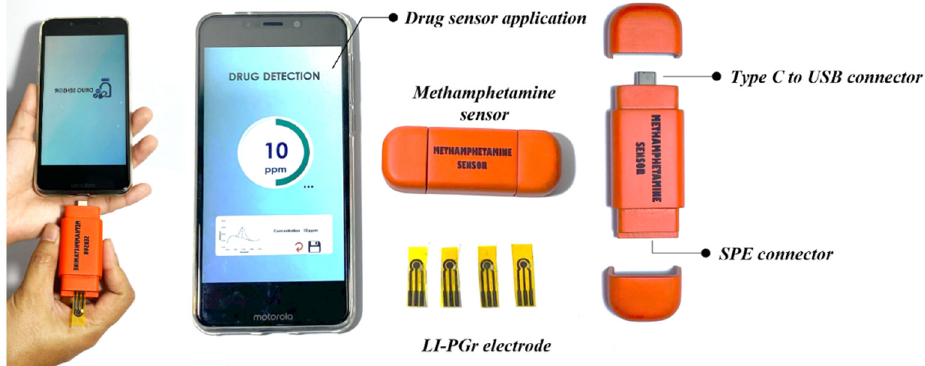
Figure 2. The components of the developed portable methamphetamine sensor.